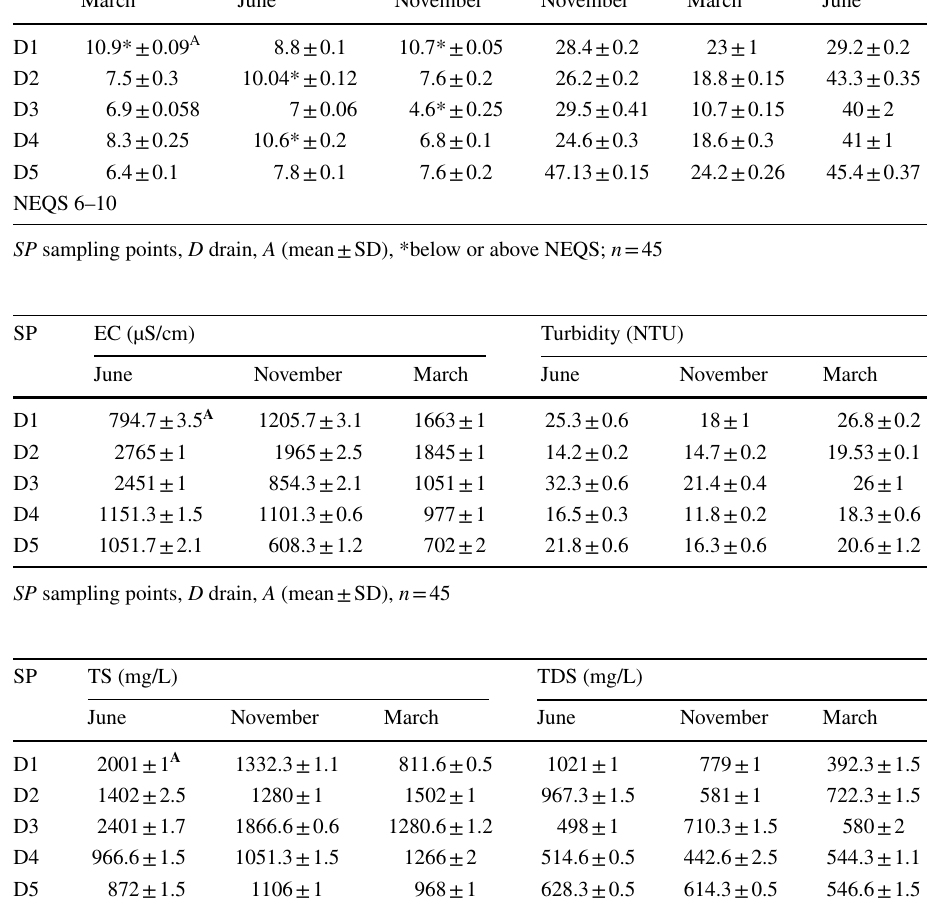
SP sampling Points, D Drain, A (mean ± SD), n